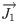
Operating principles of a traditional MRI system and of the composite right-/left-handed (CRLH) Metamaterial Ring Antenna System (MRAS).(A) A traditional body coil resonator in a birdcage low pass architecture. The coils form a standing radio-frequency field inside the biological object. (B) Sketch of an ideal experimental setup for whole-body imaging with excitation and detection performed by a CRLH MRAS fully integrated in human whole-body UHF MRI system including the patient table. Each ring antenna can act as a transmit or receive unit. J1→ is the current density.